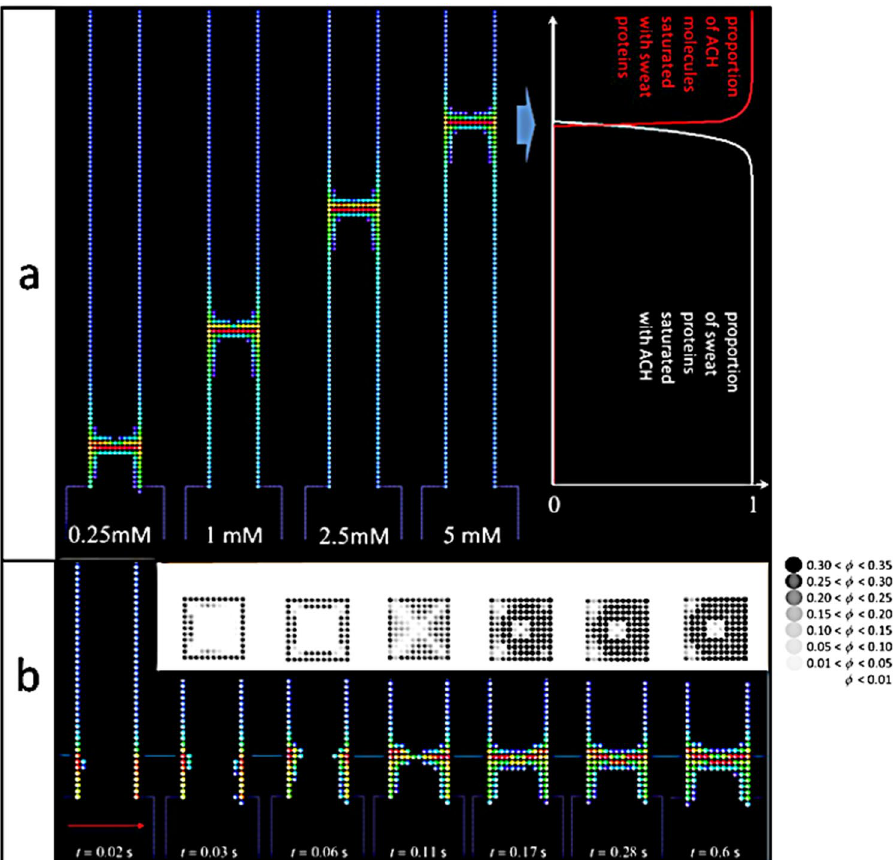
Figure 7. ( a ) Plug formation within the sweat channel in numerical 3D simulations of aqueous dispersion of sweat proteins at 1 mM, flowed at 20 μm s −1 (top to bottom), and aqueous solution of ACH molecules at four different concentrations c ACH (0.25–5 mM), flowed at 10 μm s −1 (left to right). The numerical system is as in Fig. 6 and physical time is 2 s in the four cases. Pictures are sections y = 0 of the pore. False colours correspond to gel density (same colour scale as in Fig. 6c). The data plot shows, for the c ACH = 5 mM case, the percentage of sweat proteins saturated with ACH molecules (in white colour) and of ACH molecules saturated with sweat proteins (in red) versus depth along the pore. Comparing to the picture for c ACH = 5 mM, the conclusion is that plug forms in the region where molecules are not saturated. ( b ) Successive images of plug formation at increasing times (from left to right). Only the leftmost figure shows the whole length of the pore. Constituents are 3 nm sweat proteins at 1 mM, and 1 nm ACH molecule at 1.5 mM. Sweat flows in the pore from top to bottom at 100 μm s −1 , that is a much larger than in Fig. 6. The red arrow (bottom left) represents the direction of the ACH flow at 10 μm s −1 inside the ACH channel. The six images in the top row are transversal sections of the pore at the corresponding times, at the constant depth marked by the horizontal blue line. Grey shades are used to visualize the structure of the gel (the grey map is shown on the right-hand side of the